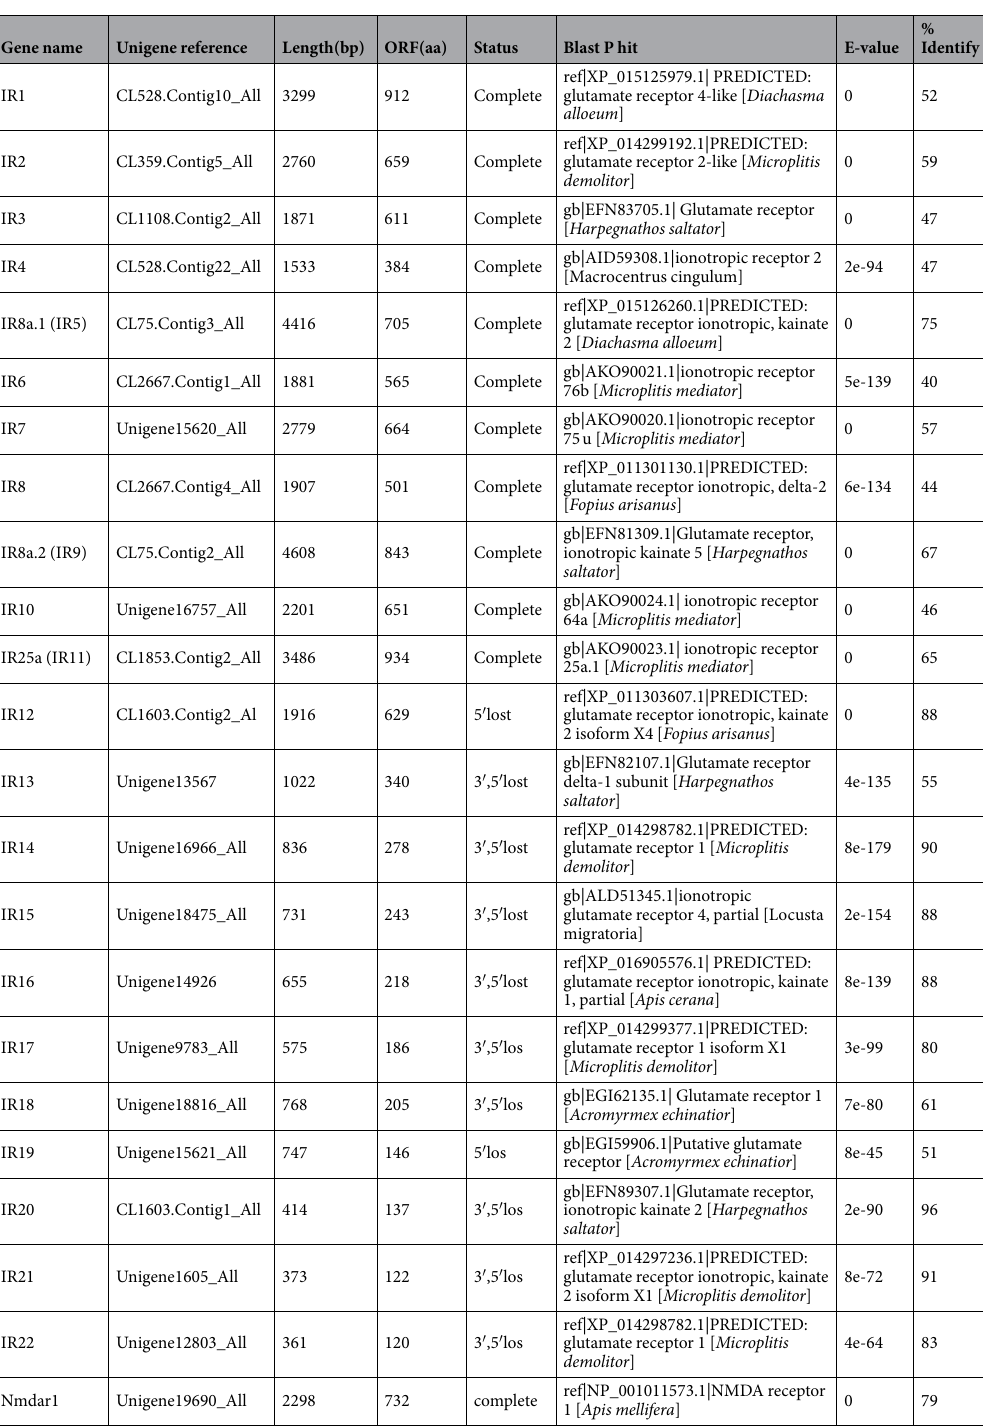
Table 3. Candidate ionotropic receptor transcripts identified in adult male and female A . gifuensis antennal